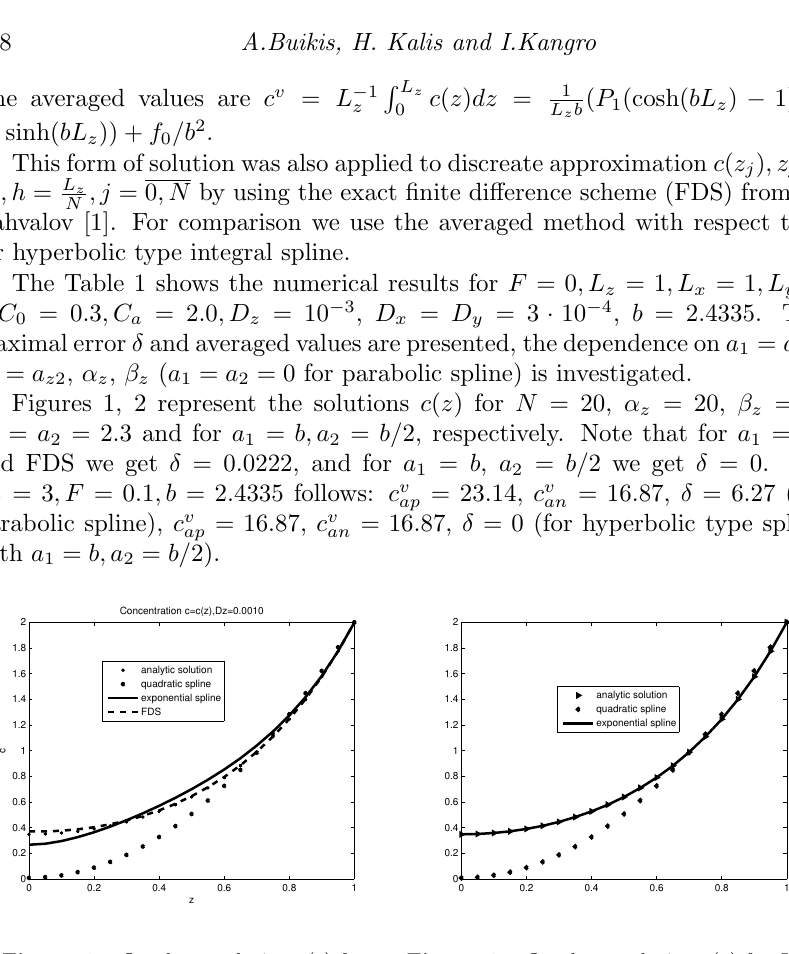
Figure 1. One layer solution c(z) for L z = 1 ,α z = 20 ,β z = 0 ,a 1 = a 2 = 2 . 3